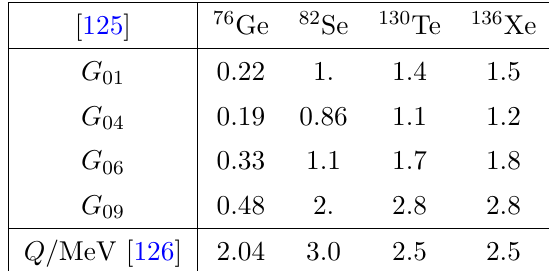
A (9) ( m ) depend on nuclear and hadronic matrix elements, the neutrino masses, and the i L;R;M Wilson coe(cid:14)cients of the higher-dimensional operators. They are discussed in detail